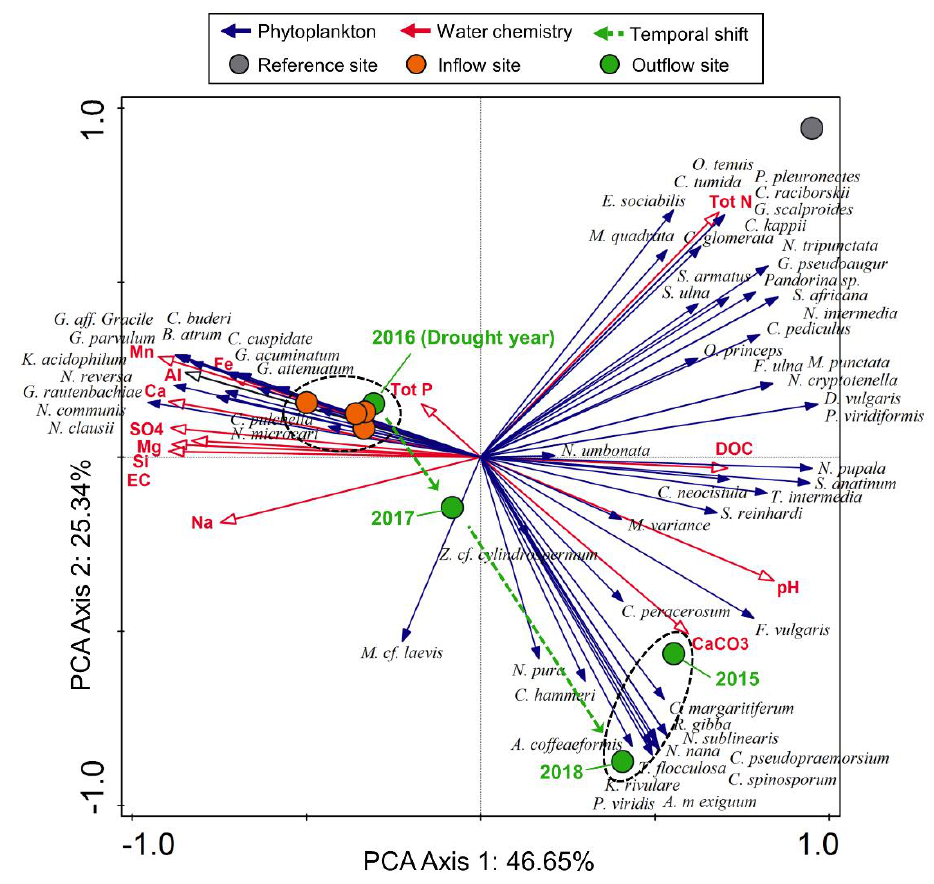
Figure 5. A principal component analysis triplot indicating the various associations between water chemistry and phytoplankton assemblage in reference to the inflow and outflow of the Grootspruit wetland and the reference site. The plot represents the entire study period (2015–2018) for the inflow and outflow locations and a reference site sampled during 2018. Phytoplankton data were applied as a focal PCA plot, and chemistry data as supplementary variables. Abbreviations: EC: electrical conductivity; Tot N: total nitrogen; DOC: dissolved organic carbon; Tot P: total